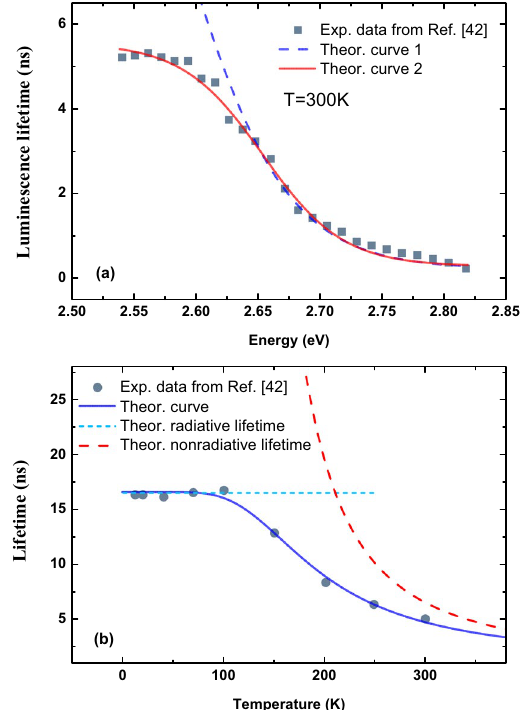
Exp. data from Ref. [42] Theor. curve 1 Theor. curve 2